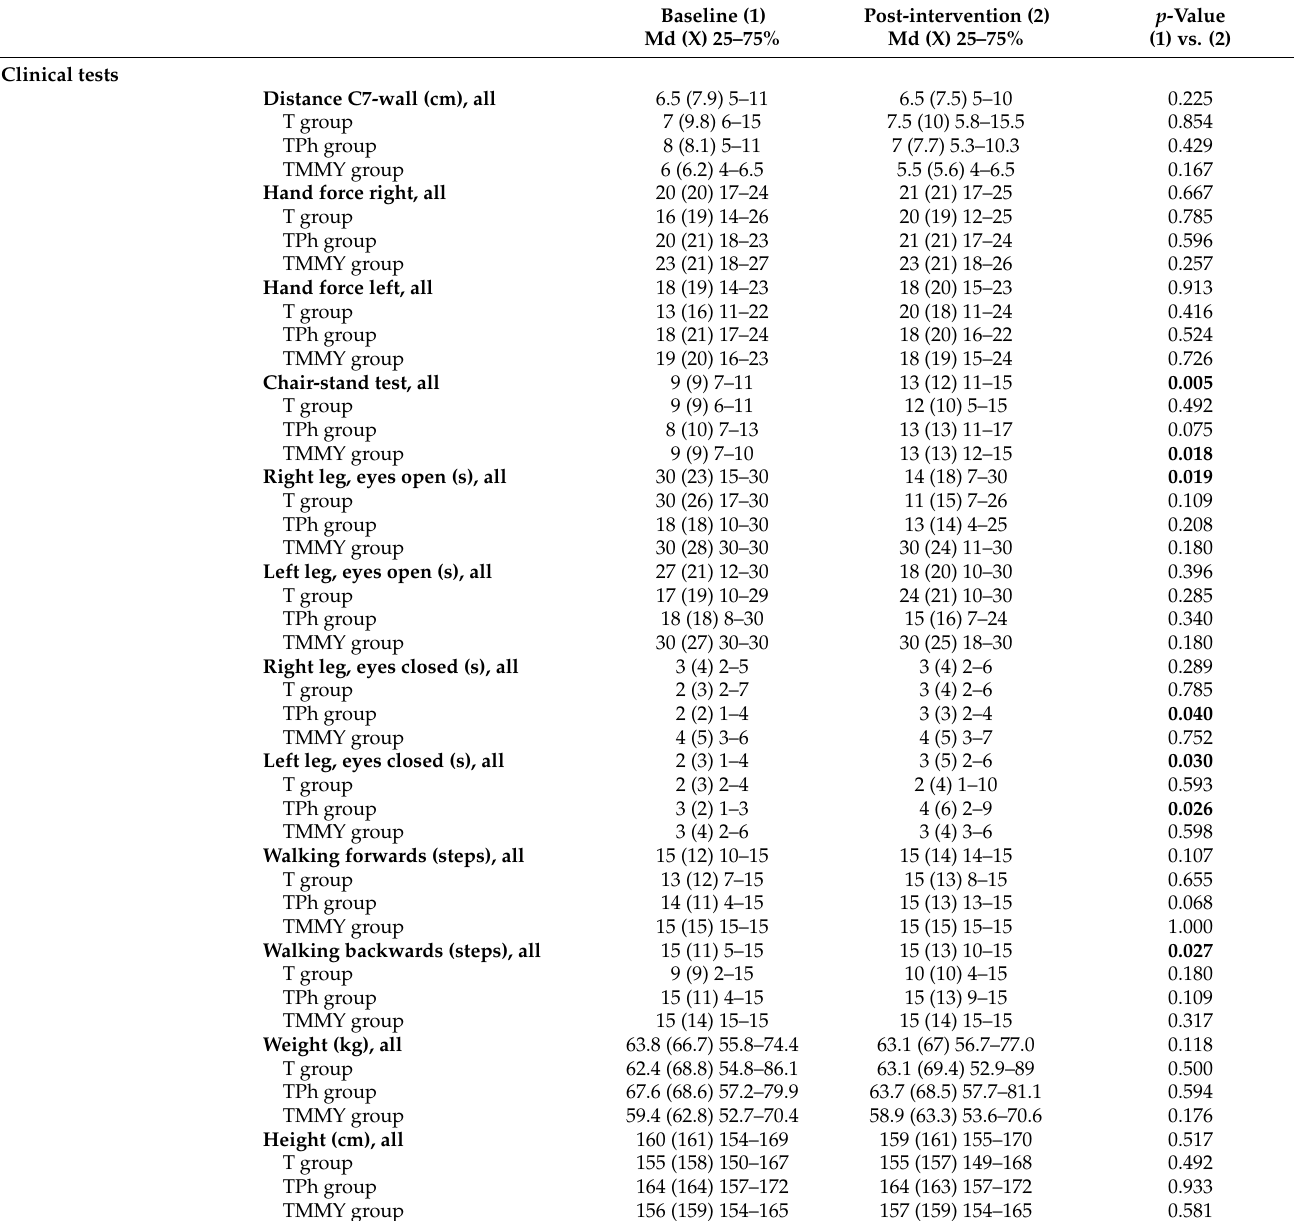
Table 4. Clinical testing outcomes and the change between the baseline and